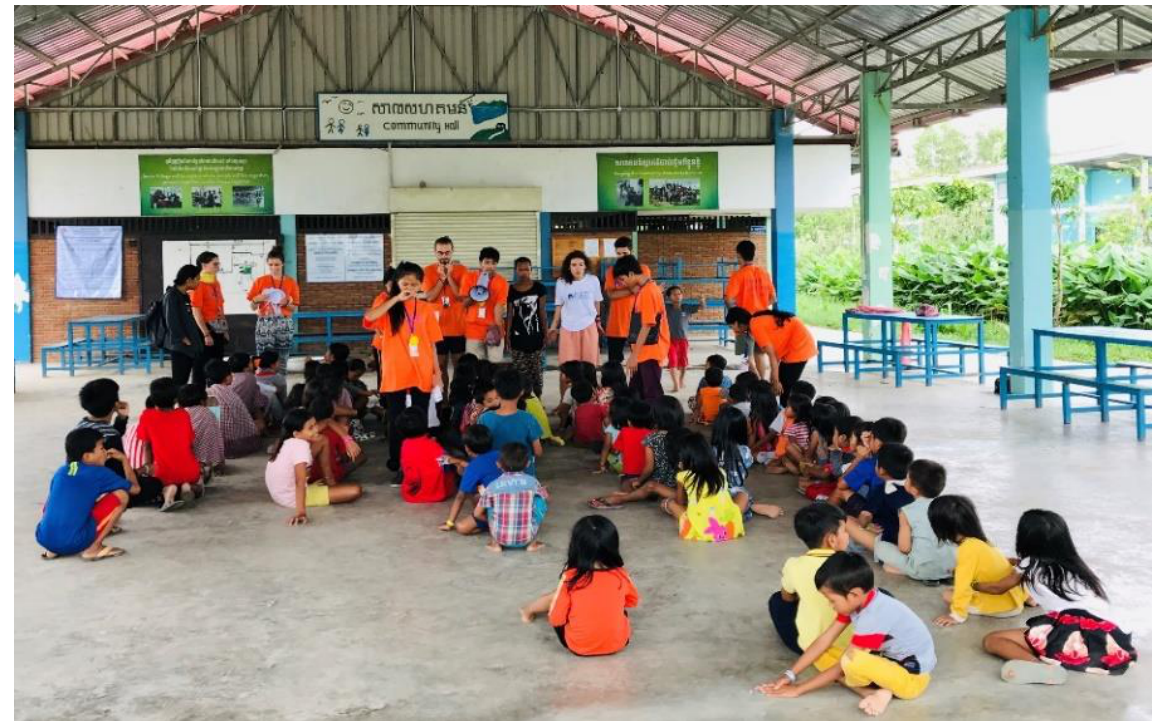
Figure 6. Teachers explaining to their children during the campaign. Source: Author.